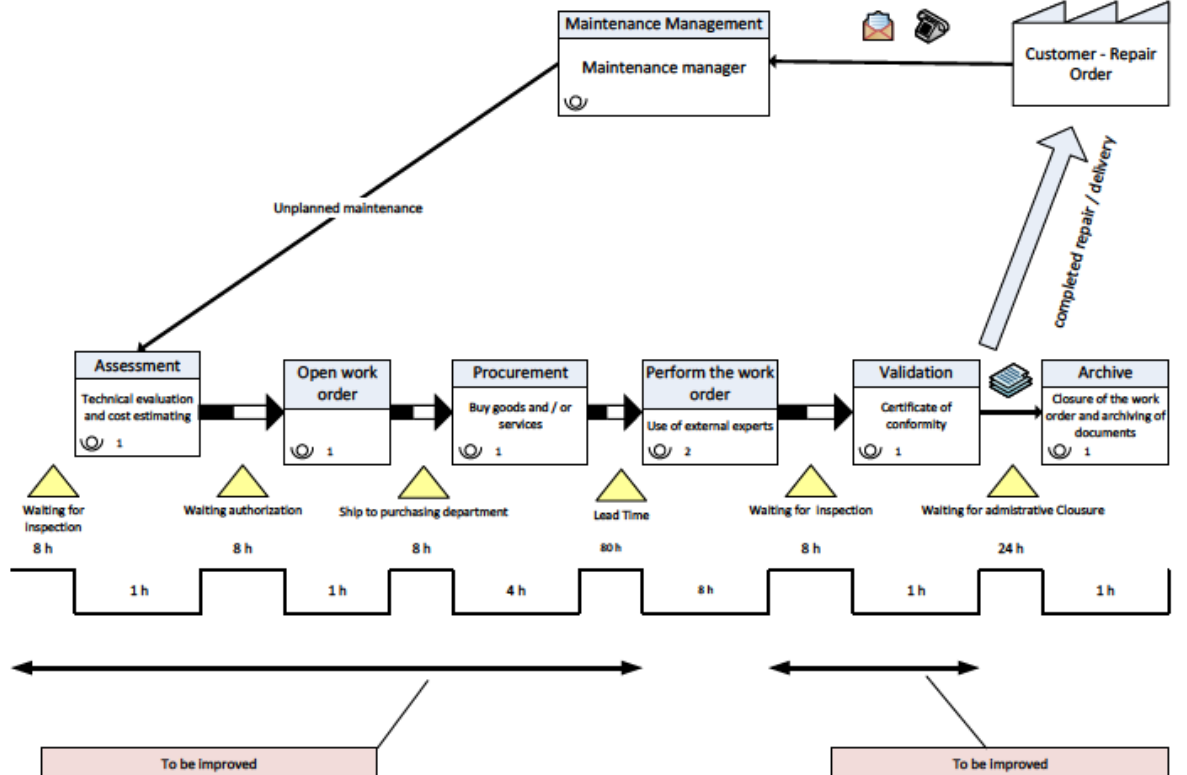
Figure 3: MVSM of a current maintenance